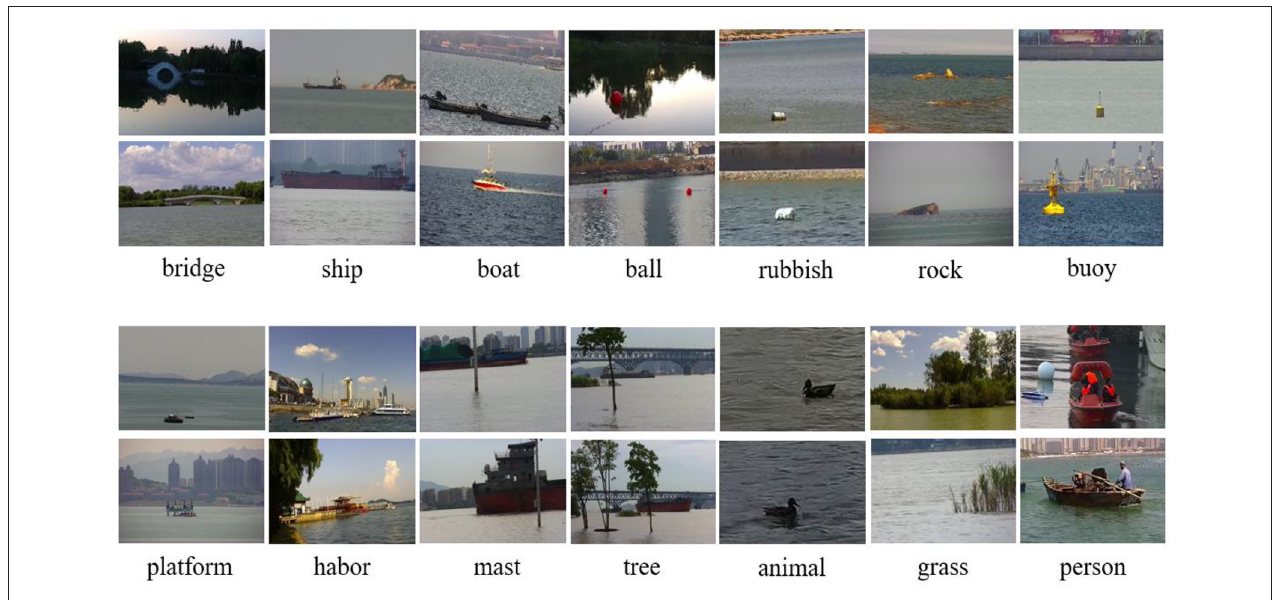
FIGURE 2 | Typical categories in WSODD.